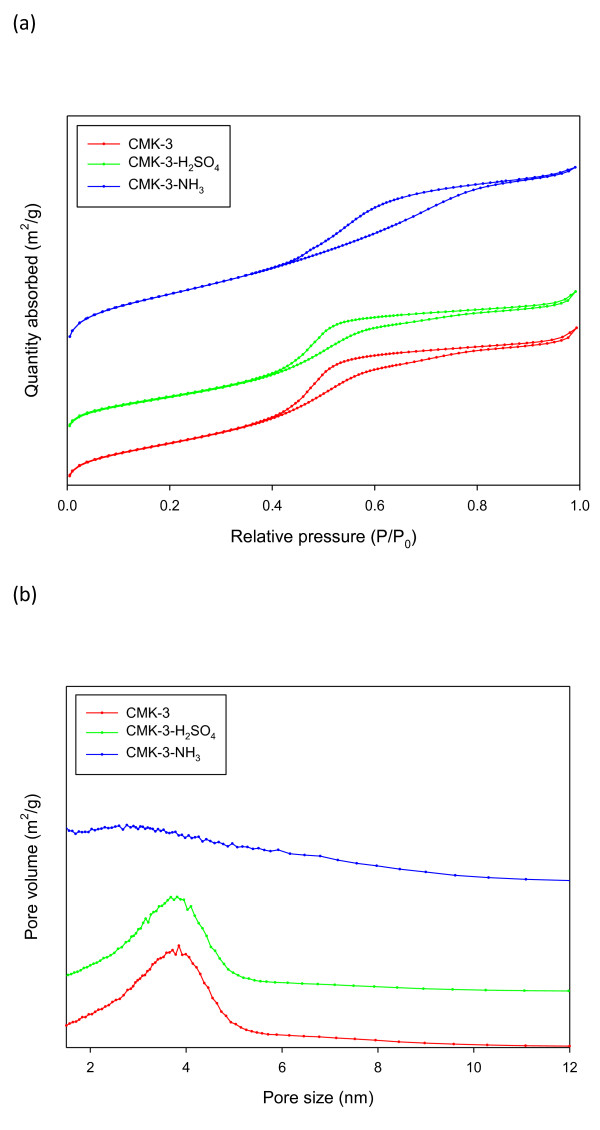
Adsorption-desorption isotherms and pore size distribution. (a) Nitrogen adsorption-desorption isotherms and (b) the corresponding pore size distribution for CMK-3, CMK-3-H2SO4, and CMK-3-NH3.